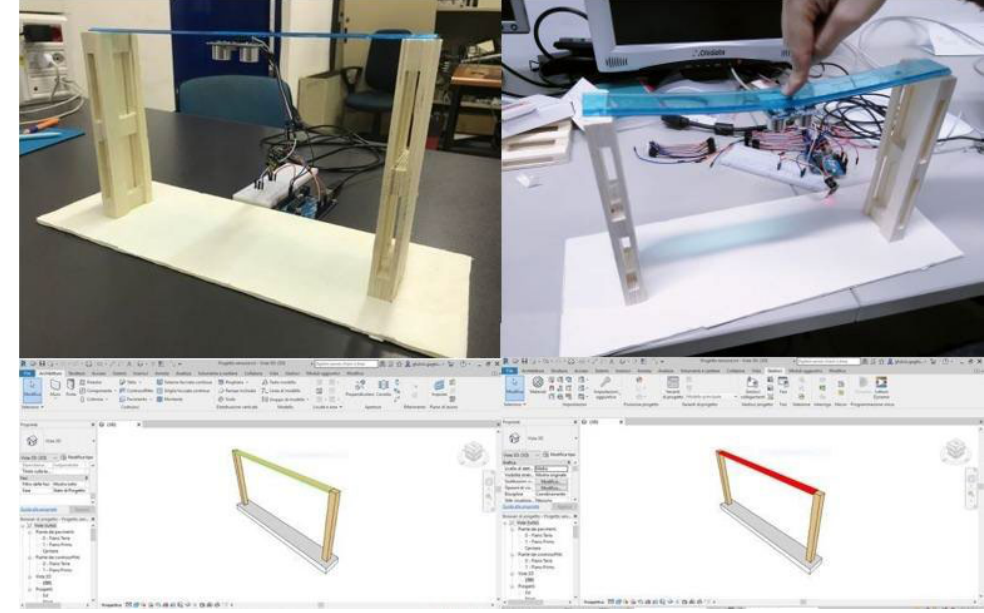
Figure 2. The simulation of behaviour of a leaning beam. Table 1. Examples of unidirectional laser radar sensors on the market useful for the monitoring of